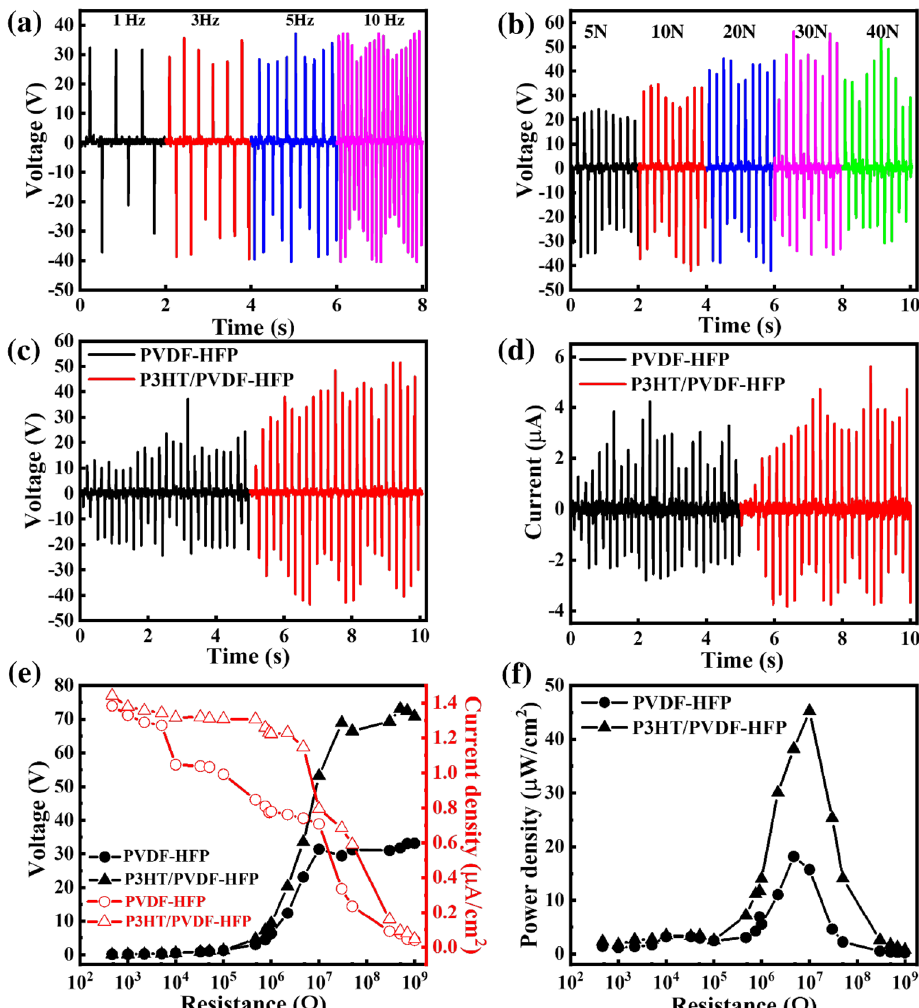
Figure 2. ( a , b ) Electrical output voltages of the P3HT/PVDF-HFP nanofibers at various ( a ) frequencies and ( b ) mechanical forces. ( c ) Maximum output voltages and ( d ) currents of TENGs composed of electrospun PVDF-HFP and P3HT/PVDF-HFP nanofibers, measured at 30 N and 5 Hz. ( e ) Output voltage and current density and ( f ) power density of the TENGs composed of PVDF-HFP and P3HT/PVDF-HFP nanofibers, plotted with respect to